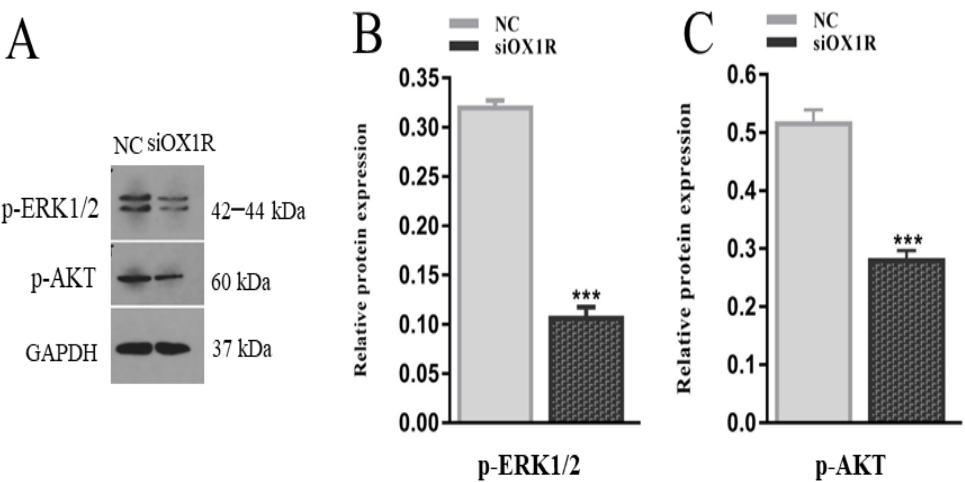
Figure 7. Effect of OX1R knockdown on the phosphorylation level of the AKT and ERK1/2 proteins in mouse GCs. ( A – C ) Mouse GCs were transfected with siOX1R for 48 h, and the protein was extracted for Western blot analysis of the phosphorylation level of the AKT and ERK1/2 proteins. The Western blot results were standardized with GAPDH and are presented as the means ± SEM. The significant differences between the siOX1R-transfected cells groups and the negative control group is indicated with error bars with asterisks (*** p < 0.001). OX1R, orexin receptor type 1; NC, negative control; GCs, granulosa cells; siOX1R, orexin receptor type 1 siRNA; AKT, Akt serine/threonine kinase; ERK, extracellular signal-regulated kinase.